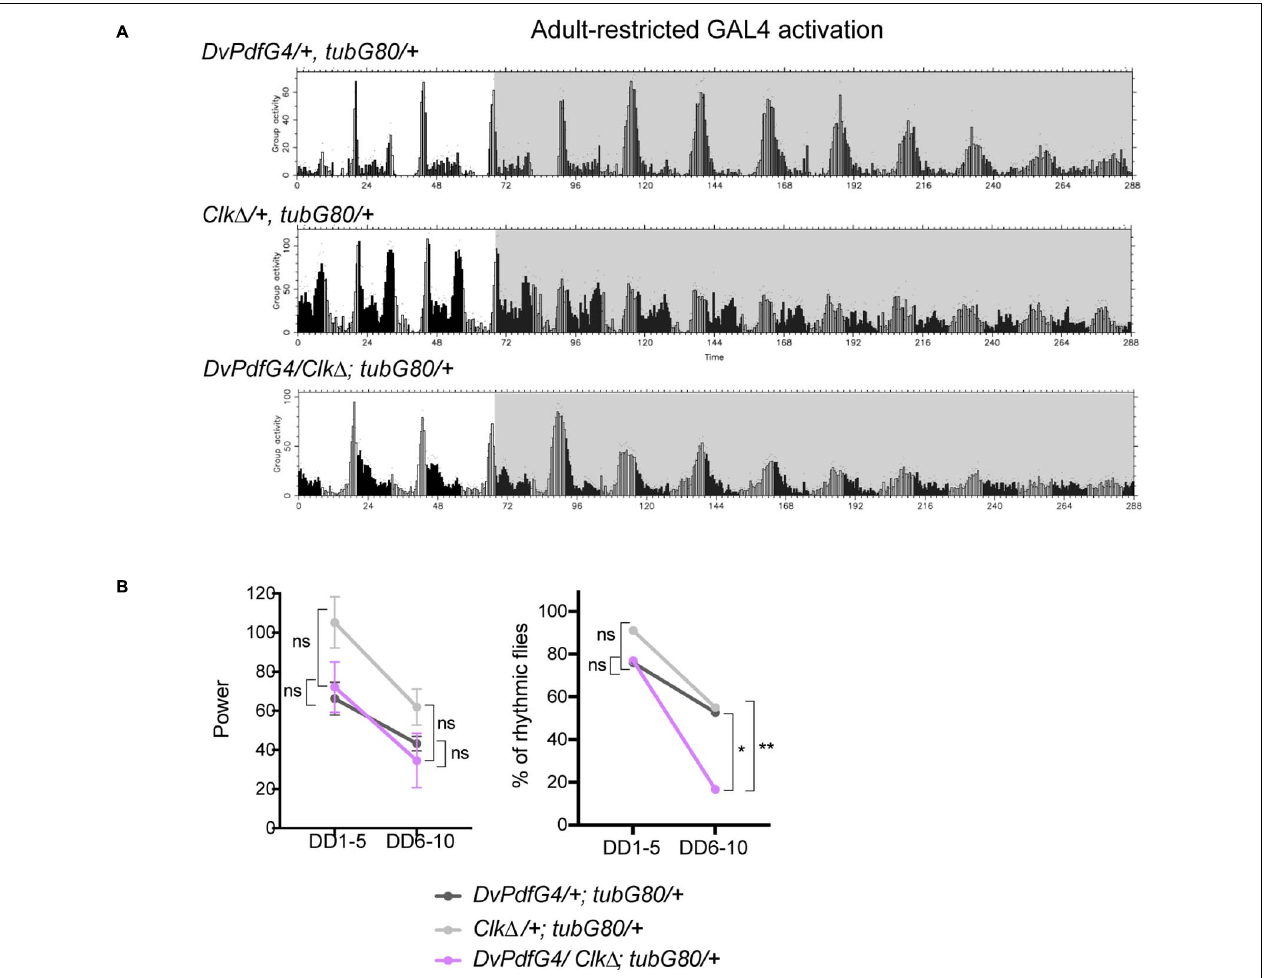
FIGURE 5 | Adult-restricted expression of CLK (cid:49) with the DvPdf-GAL4 driver has little effects on free-running locomotor rhythms. (A) Group average locomotor activity in LD and DD in the flies expressing CLK (cid:49) with the DvPdf-GAL4 driver during adulthood and their controls. (B) Left, the rhythm power of flies in DD1-5 and DD6-10. Right, percentage of rhythmic flies. * p < 0.05, and ** p < 0.01 by Fisher’s exact